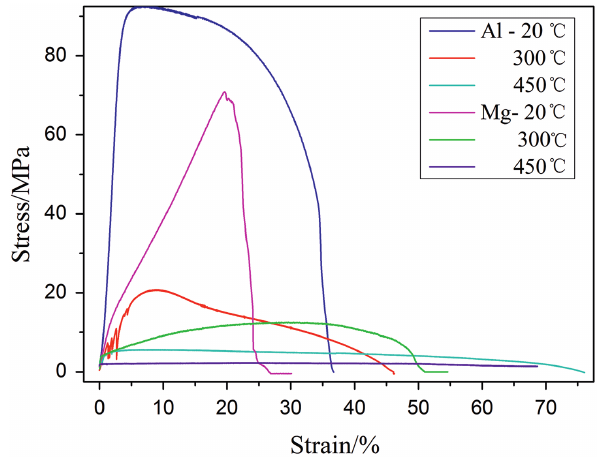
Figure 3: Tensile properties of matrixes at various